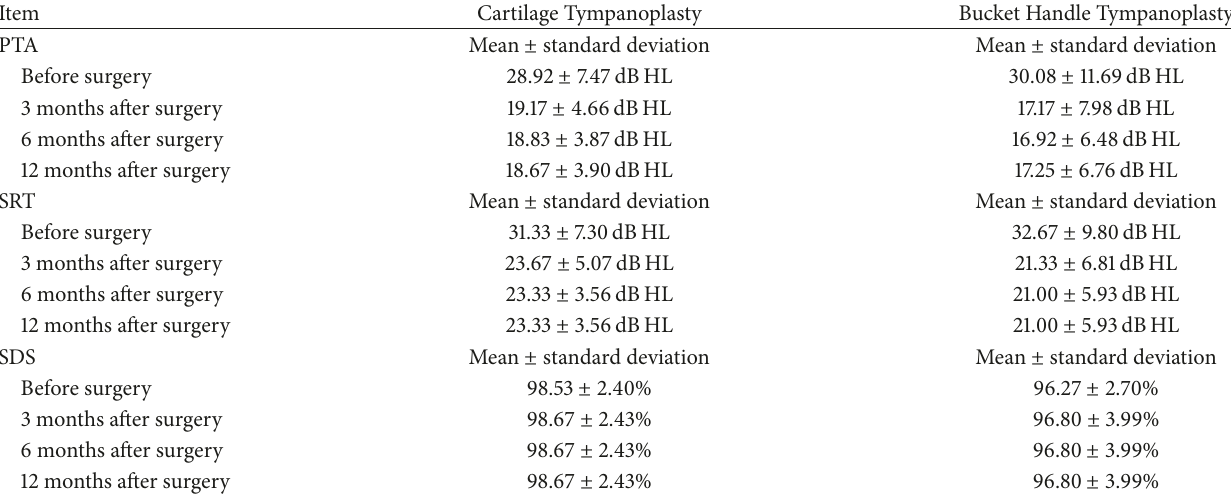
Table 2: The change in PTA, SRT, and SDS parameter in both groups within the follow-up